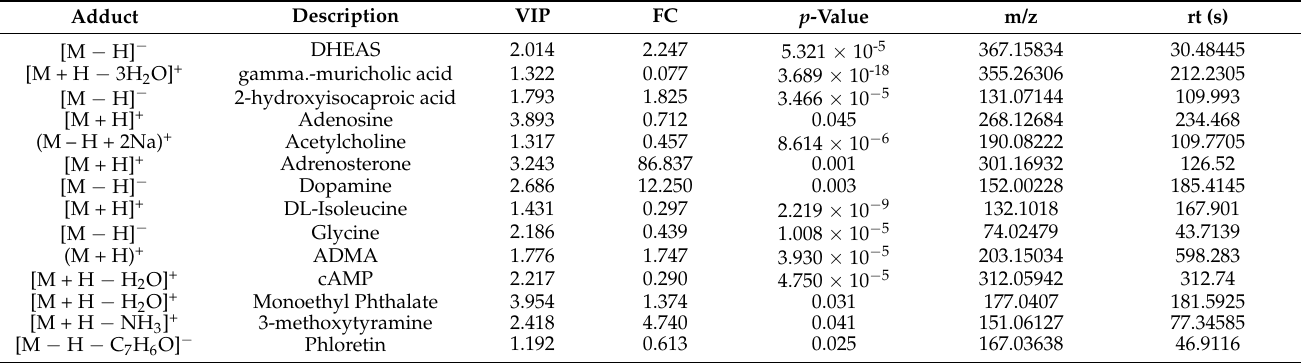
Table 2. Some significantly different metabolites between hypertension groups and normal